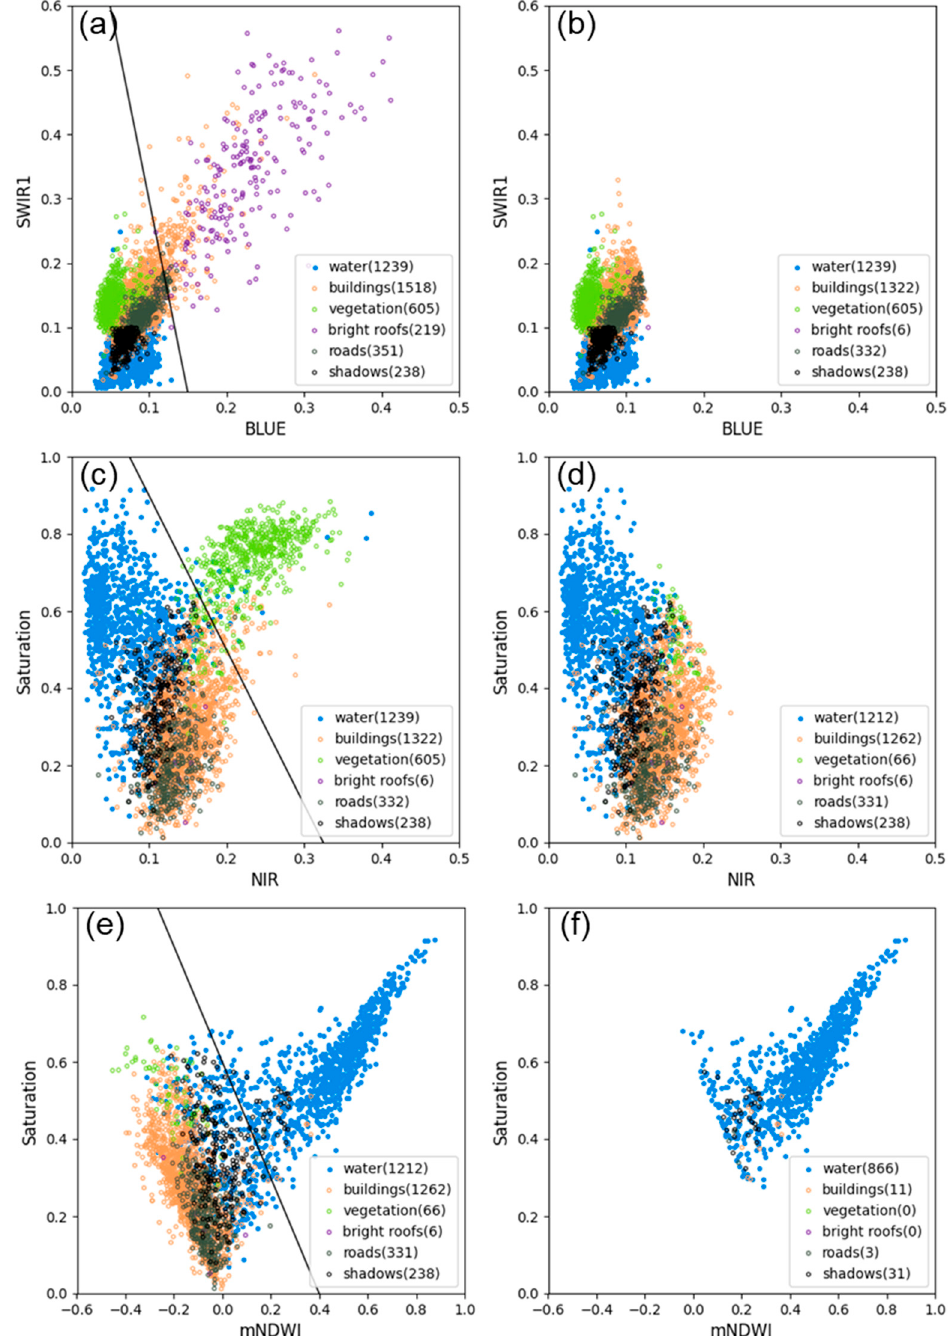
Figure 4. Segmentation of UWEA on sample points. The black line is the segmentation function of each step; ( a , c , e ) are the points of each land cover type before the segmentation, and ( b , d , f ) are the each step; ( a ), ( c ), and ( e ) are the points of each land cover type before the segmentation, and ( b ), ( d ), and ( f ) are the points that remained after the segmentation. points that remained after the